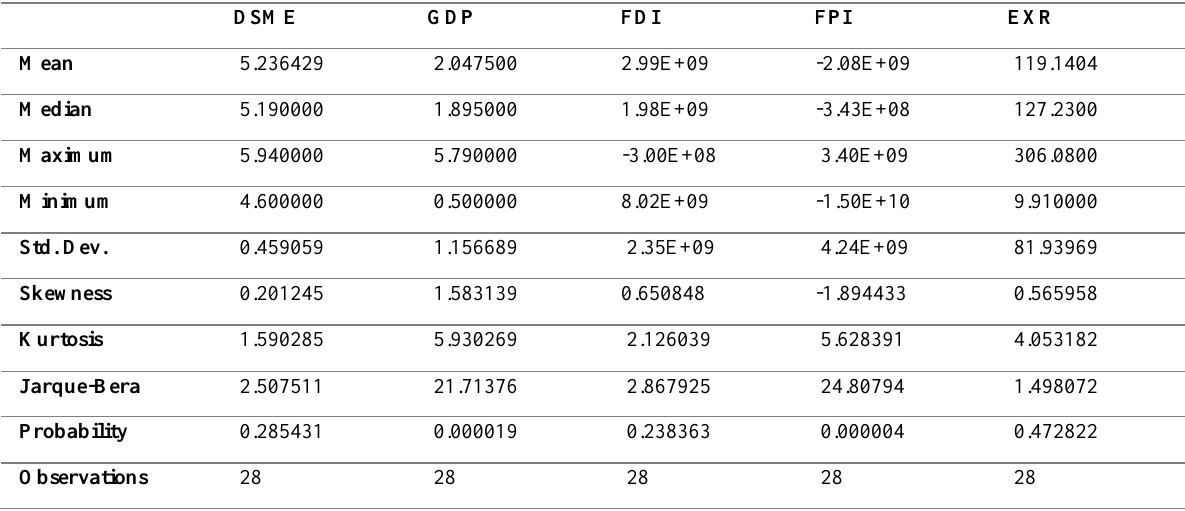
Table 4: Descriptive Statistics of the